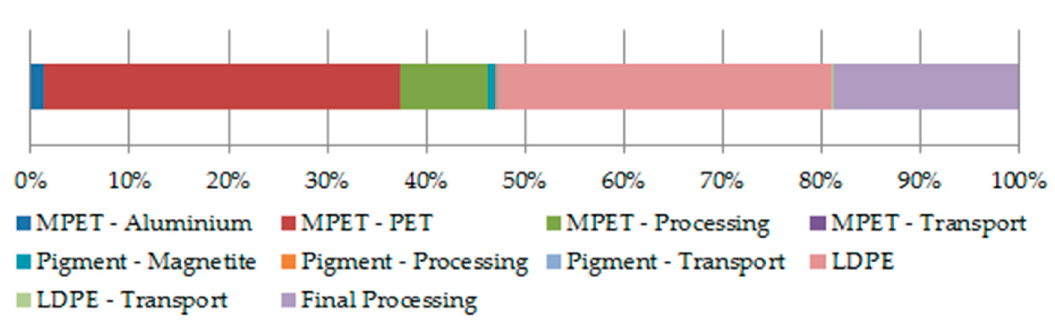
Figure 4. Shares of individual materials and processes relative to the sum of normalized environmental impacts.